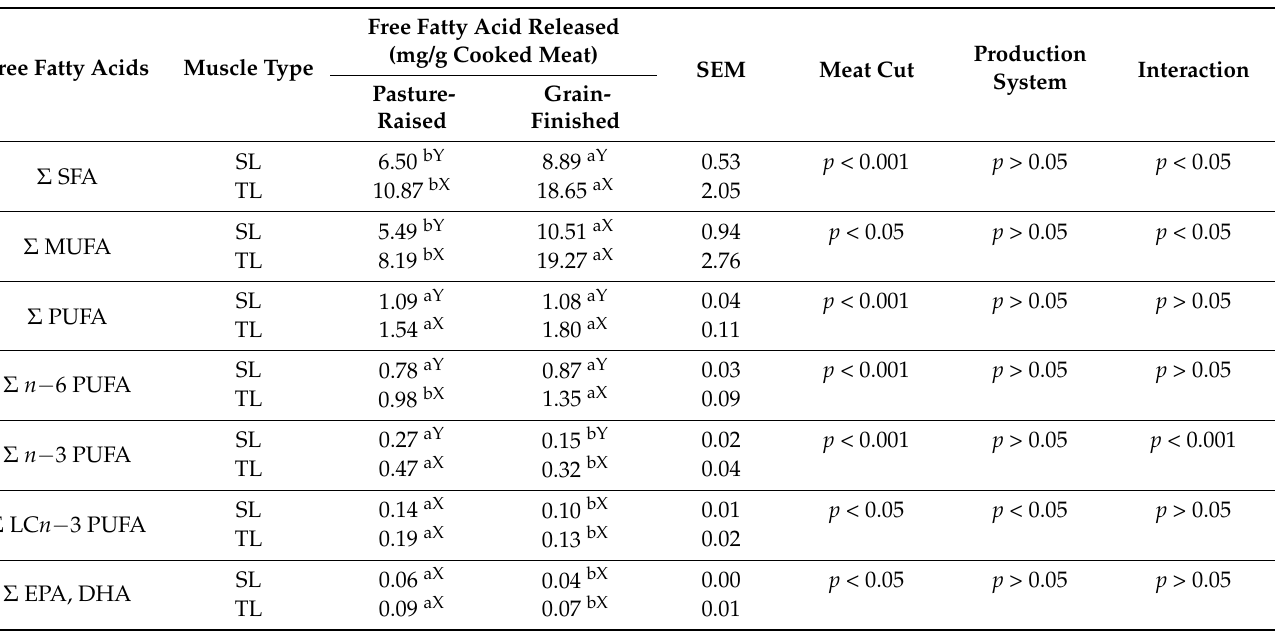
Table 5. Sum of the released free saturated (SFA), mono- (MUFA) and polyunsaturated fatty acid (PUFA) amounts for cooked striploin (SL) and tenderloin (TL) digests from pasture-raised and grain-finished animals after 180 min of digestion under simulated gastro-small intestinal